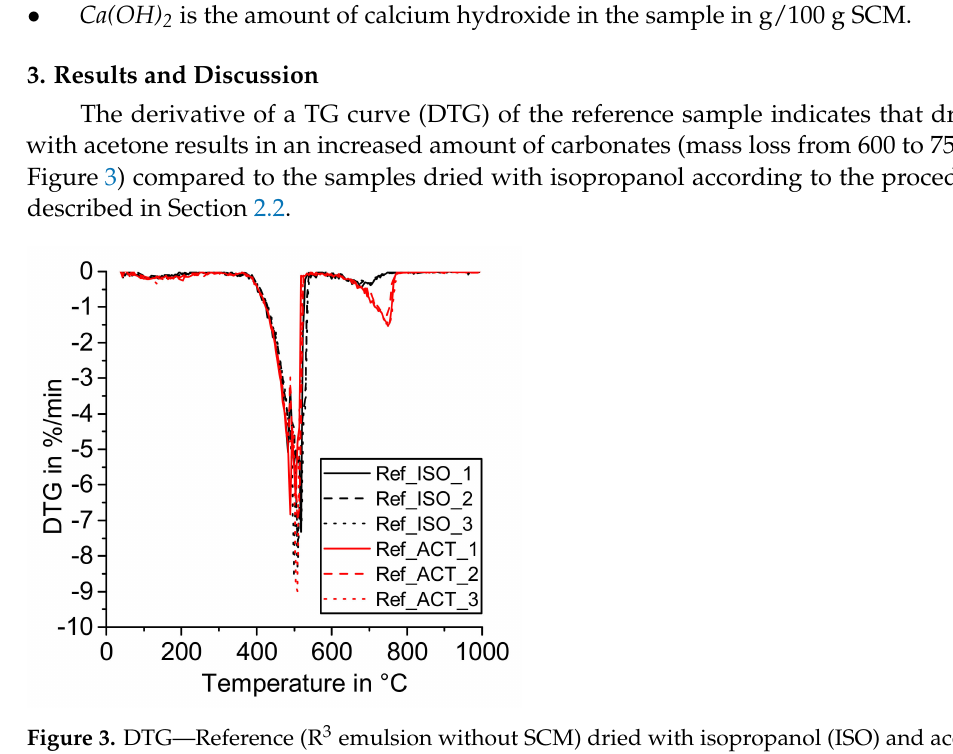
Figure 3. DTG—Reference (R 3 emulsion without SCM) dried with isopropanol (ISO) and acetone